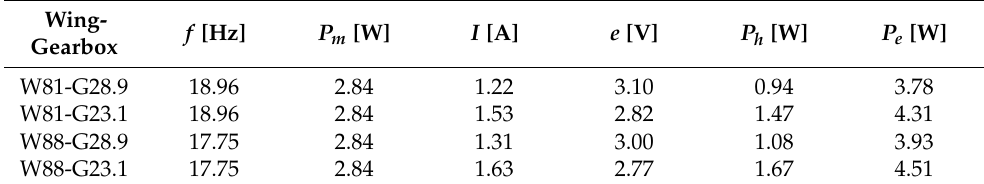
Table 4. Single battery B3 and Motor M1: Influence of the wing size and the gearbox. Flapping frequency f , mechanical power P m , current I , voltage e , heat power P h and total electric power P e . The lift is L = 21.6 gr in all cases. Wing-